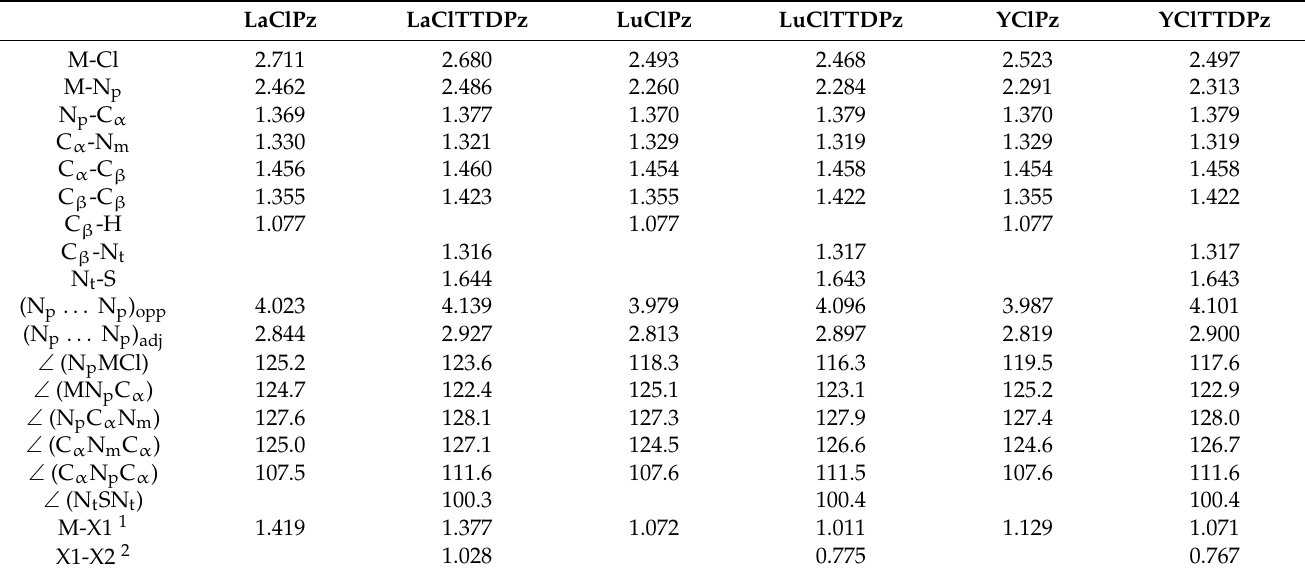
Figure 1. Molecular models of porphyrazine (MClPz) ( a ) and tetra(1,2,5-thiadiazolo)porphyrazine (MClTTDPz) ( b ) com- plexes with atom labeling (M = Y, La, Lu). Table 1. Internuclear distances (r e , in Å) and valence angles ( ∠ , in deg.) of the equilibrium C 4v structures by B3LYP/pcseg-2 calculations.